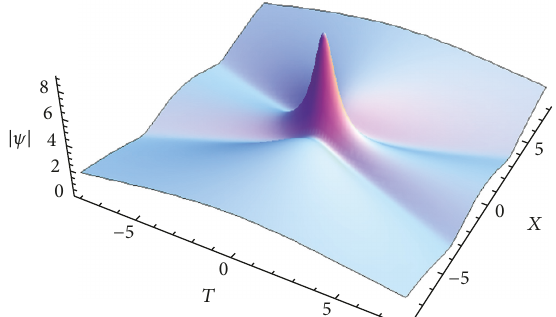
Figure 18: Rouge wave structure determined by the module of solution (83).